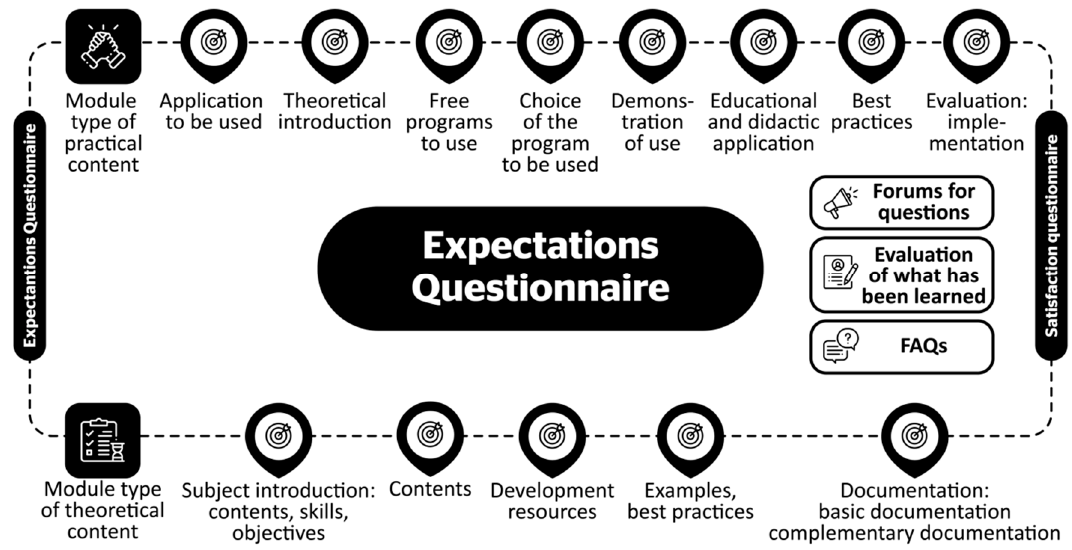
Figure 5. Virtual course structure.